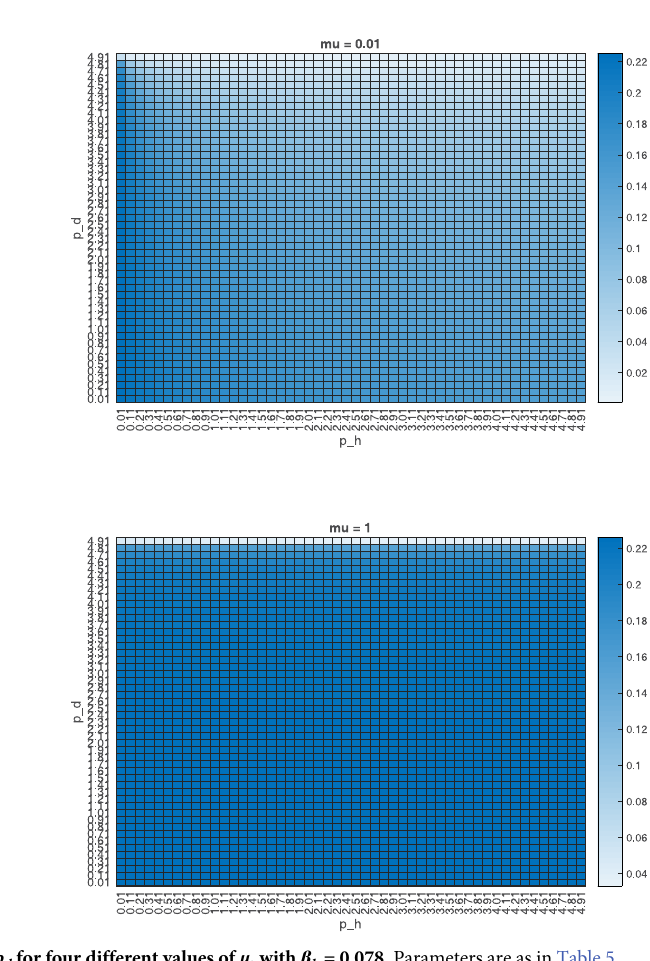
Fig 4. Graphing the equilibrium proportion of infected humans ( I h ) against p h and p d for four different values of μ , with β h = 0.078. Parameters are as in Table 5, with β = β = 0.118 � 5. While intracompartmental reproductive numbers vary between simulations, R 0 for all four simulations is 2.2463. w d